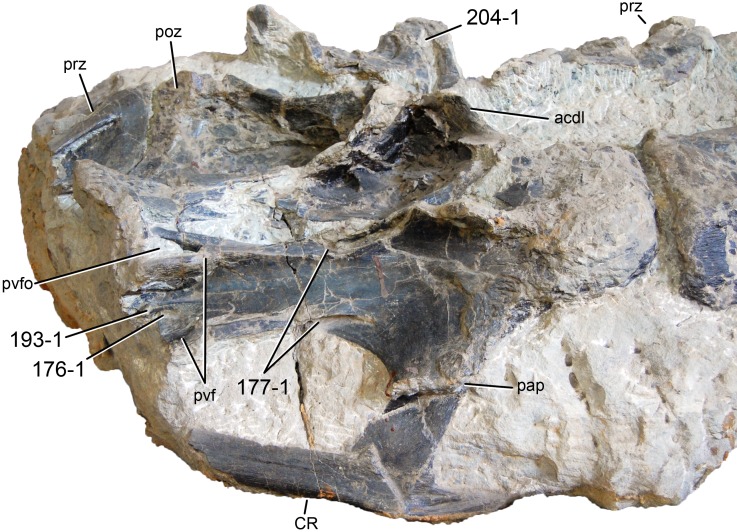
Cervical vertebra 14 of “Dinheirosaurus” lourinhanensis ML 414 in lateroventral view.Note the particular ventral morphology with posteriorly located paired pneumatic foramina (C176-1), lateral grooves posterior to the parapophyses (C177-1), a posteriorly restricted ventral keel (C193-1), and the elongated lateral spinal cavity (C204-1). Abb.: acdl, anterior centrodiapophyseal lamina; CR, cervical rib; pap, parapophysis; poz, postzygapophysis; prz, prezygapophysis; pvf, posteroventral flanges; pvfo, posteroventral fossa.